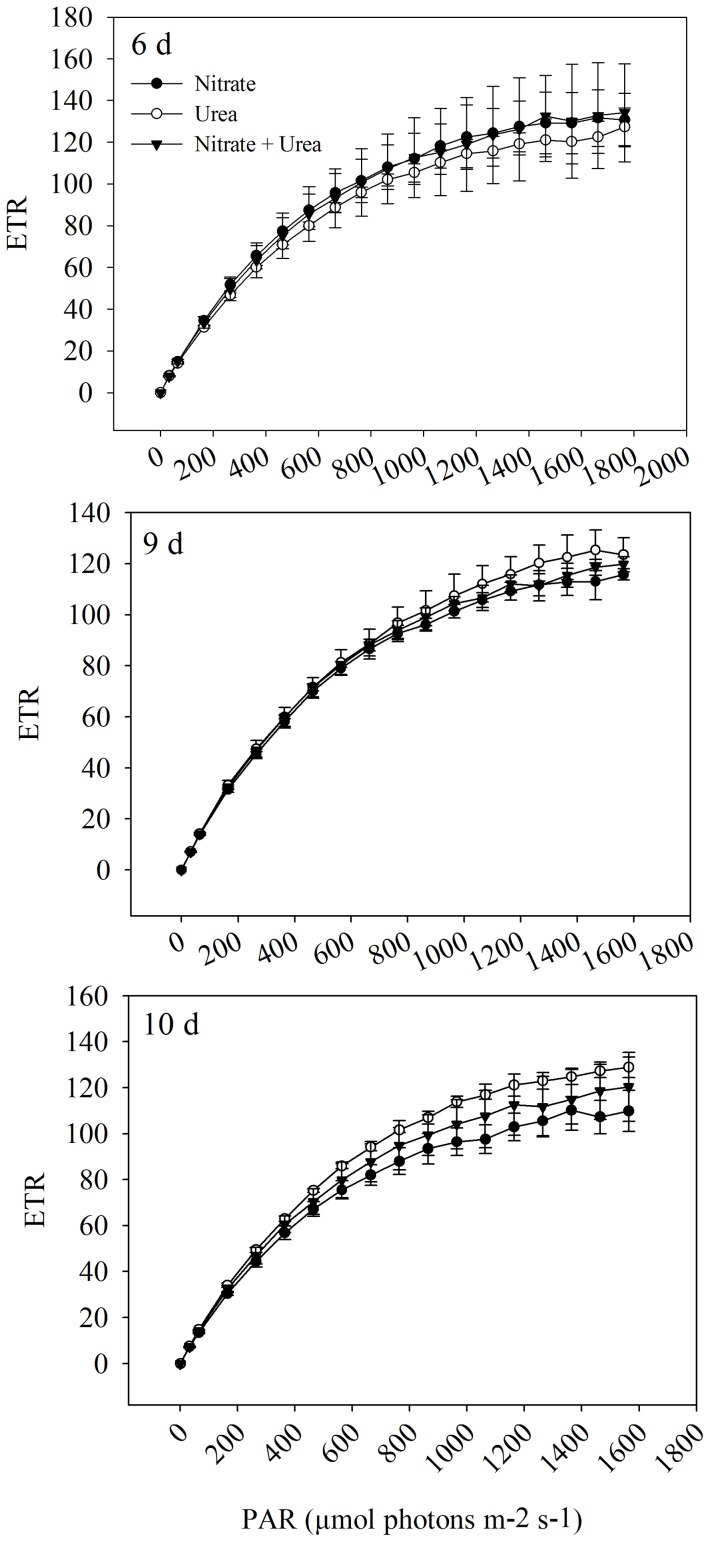
Relative electron transport rate (ETR) as a function of PAR.
A. anophagefferens was grown on urea, nitrate, and a mixture of urea and nitrate, and samples were meaused at the 6-, 9- and 10-day. Error bars represent standard deviation of the mean for the three biological replicates.